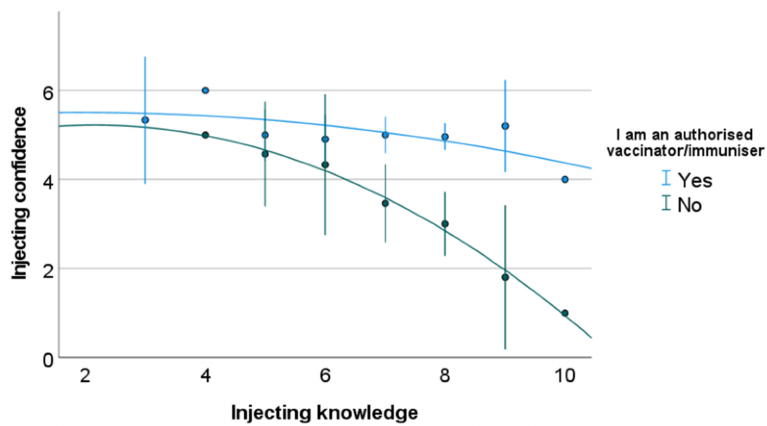
Figure 7. Non-linear correlation between confidence and knowledge of safe injecting practices, between authorised immunisers and non-immunisers. Key: Error bars = 95% Confidence